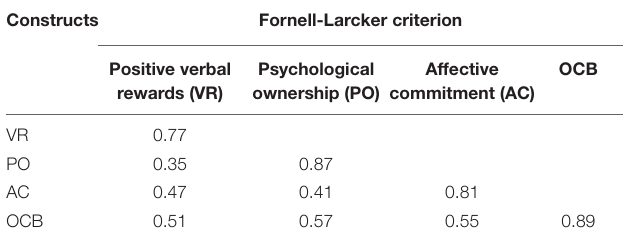
TABLE 3 | Analysis of discriminant validity.